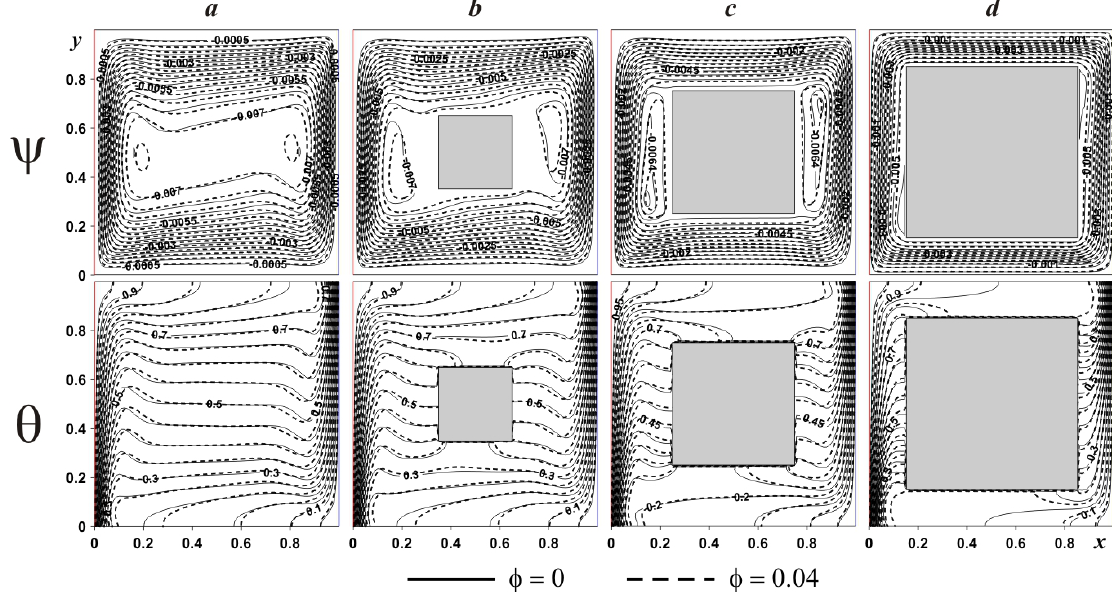
Figure 11. Isolines of ψ and θ for adiabatic internal body at Ra = 10 6 and di ff erent δ and φ : ( a )— δ = 0.0, ( b )— δ = 0.3, ( c )— δ = 0.5, ( d )— δ = 0.7.